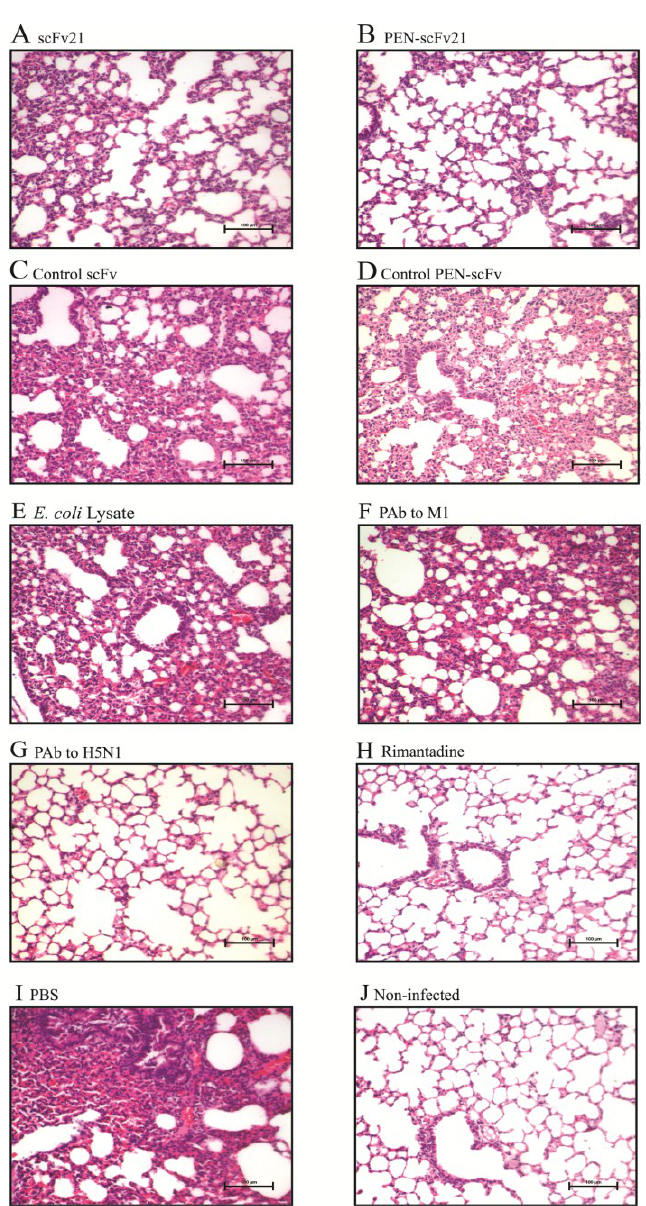
Figure 6. Histopathological features in lung sections of mice infected with 10 MLD 50 of mouse adapted A/chicken/Thailand/NP-172/2006 (H5N1) at 96 h post infection in comparison with the lung section of a normal mouse. ( A – H ) Infected mice treated with 10 mg/kg body weight of scFv21, PEN-scFv21, control scFv, control PEN-scFv, E. coli lysate, PAb to M1, PAb to H5N1 and rimantadine; ( I ) Infected mouse treated with PBS and ( J ) normal mouse (H & E; 20× original